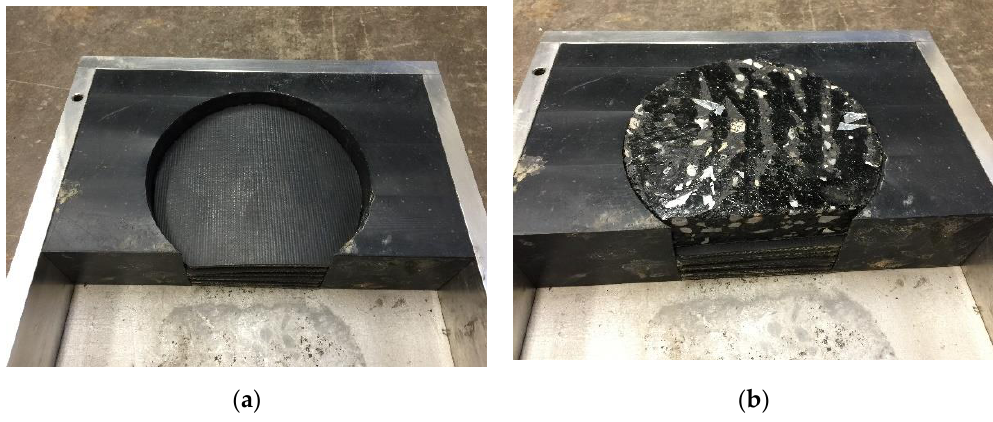
Figure 3. ( a ) Rubber placed at the bottom of the mold, and ( b ) specimen placed on top of the rubber.